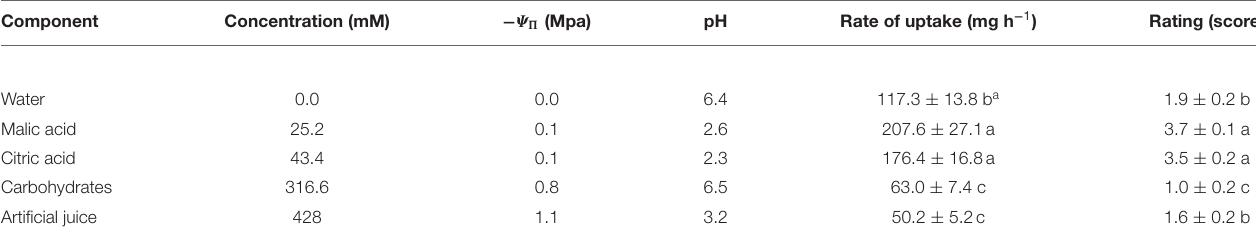
TABLE 2 | Effect of major osmolytes on the rate of water uptake and the development of water soaking in strawberries of cultivar “Florentina.” Component Concentration (mM)